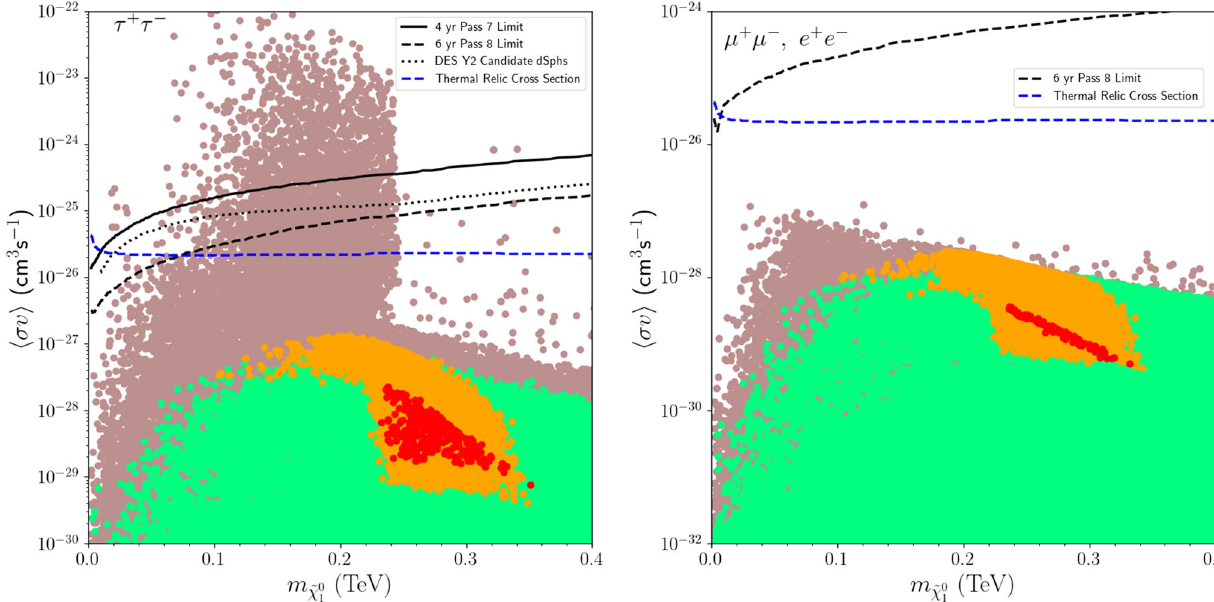
Fig. 11 The results for the indirect detection of DM in the (cid:11) σv (cid:12)− m ˜ χ 0 planes for the annihilation of the LSP neutralino into τ ¯ τ (left) and l ¯ l with l = e ,μ (right). The color coding is the same as in Fig. 6. The dashed black curves in the planes represent the 6 year Pass 8 Limit from